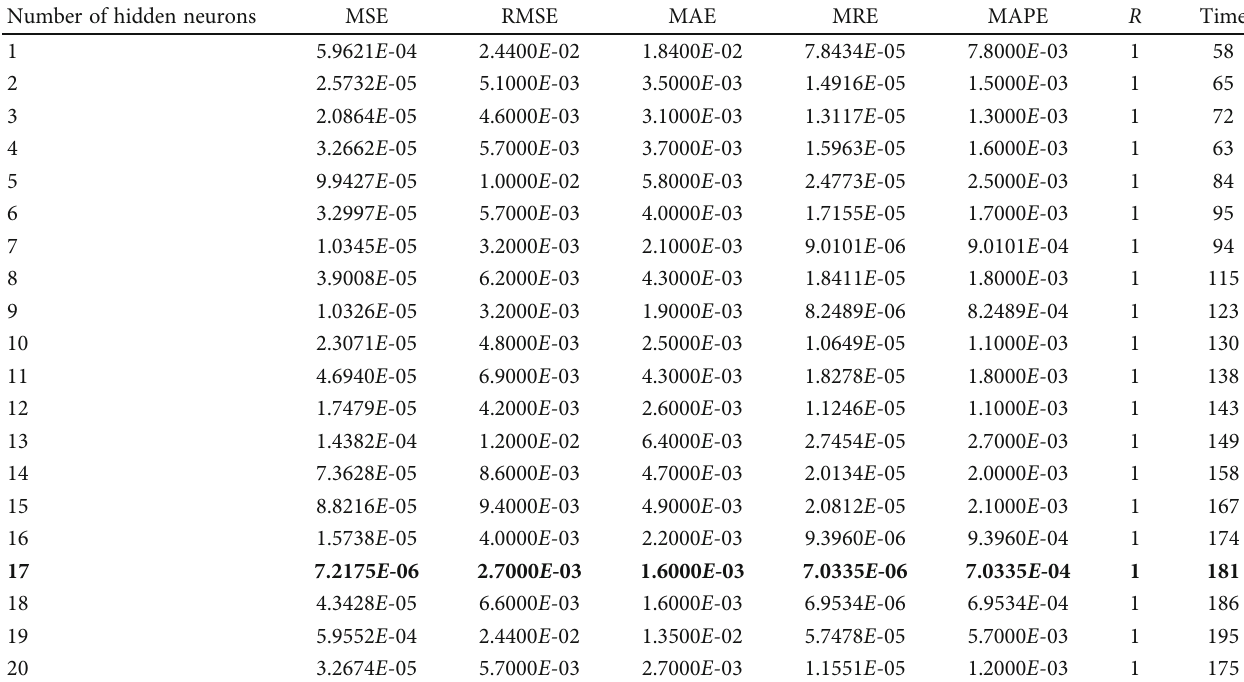
Table 3: Two input multilayer perceptron neural network performance analyses with di ff erent numbers of hidden neurons. Number of hidden